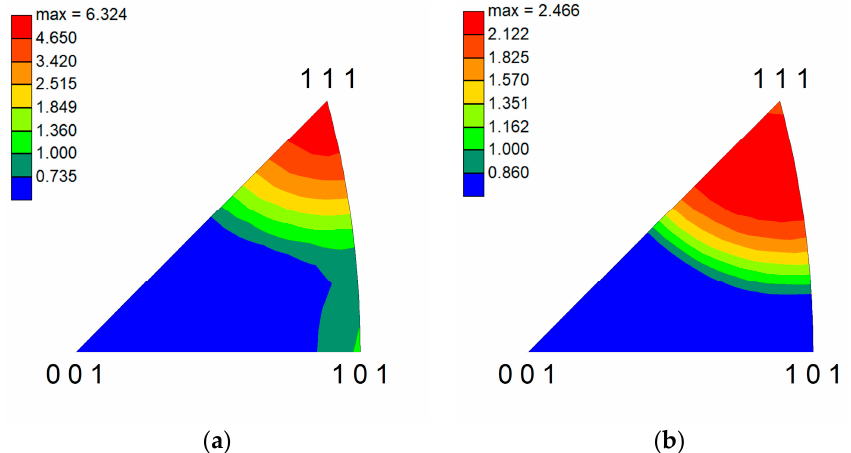
Figure 6. Inverse pole fi gures along rolling direction for the annealed Ti 50 Ni 47 Fe 3 alloys. ( a ) 400 °C/60 min/AC; and ( b ) 600 °C/60 min/AC.